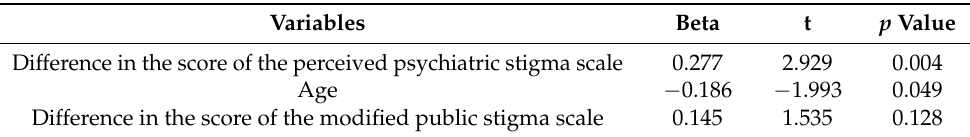
Table 4. Multiple regression analysis with the difference in the score of modified social distance scale as the dependent variable. Variables Beta t p Value Difference in the score of the perceived psychiatric stigma scale 0.277 Age − 0.186 0.049 Difference in the score of the modified public stigma scale 0.145 1.535